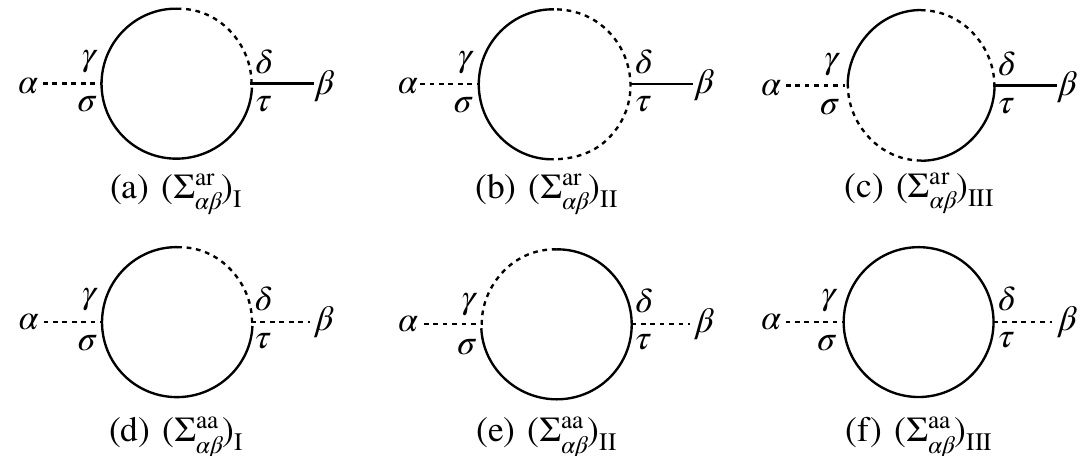
Figure 3 . Self-energies at the one-loop